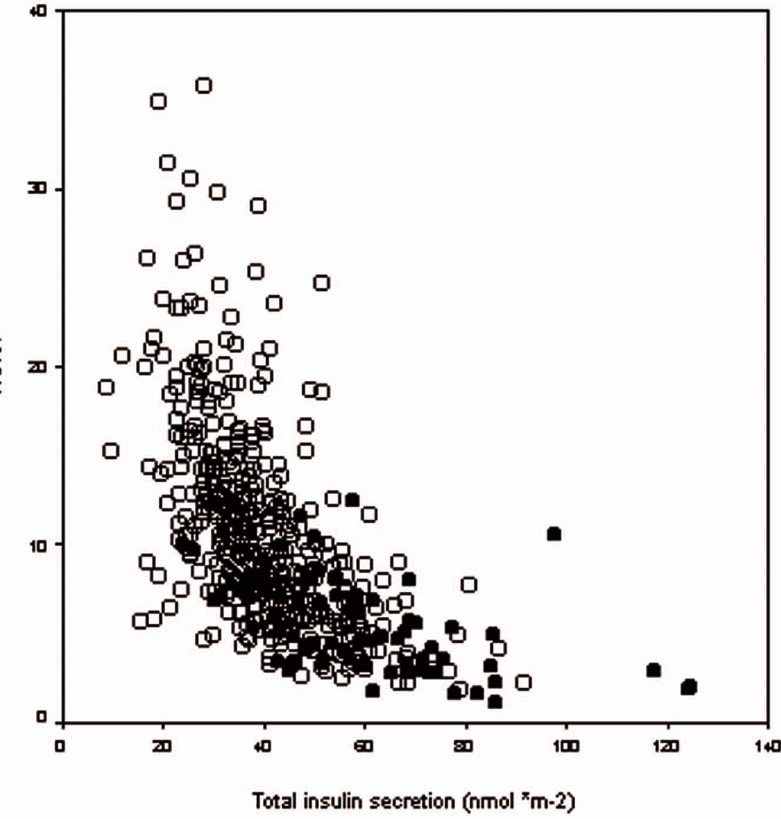
Figure 1. Relationship between insulin sensitivity and secretion in cases and controls. Scatter plot of the relationship between whole body insulin sensitivity (WBISI) and Total insulin secretion in controls (empty circles) and patients with PCOS (filled circles).